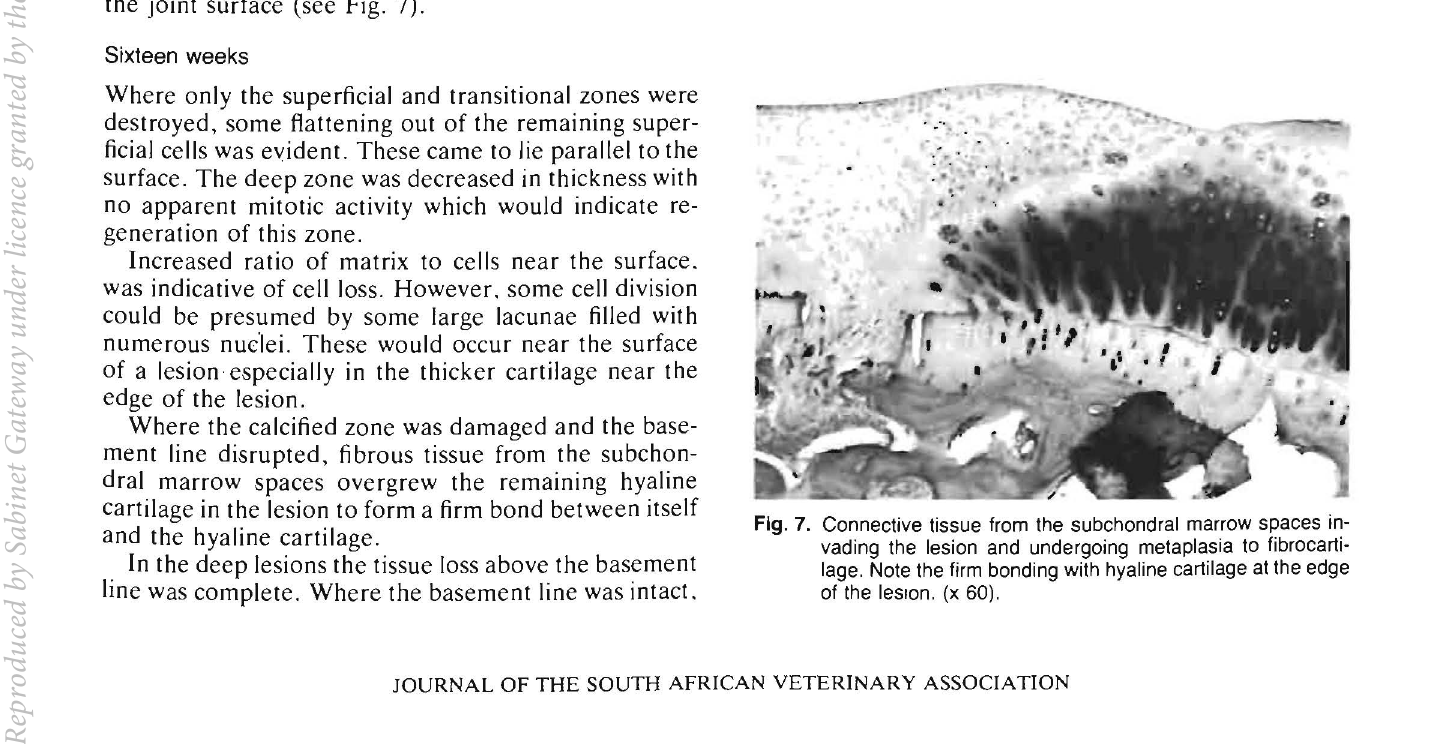
Fig. 6. Deep lesion showing complete loss of cartilge above base ment line. and subchondral bone buds reaching the base ment line from below. (x 60)